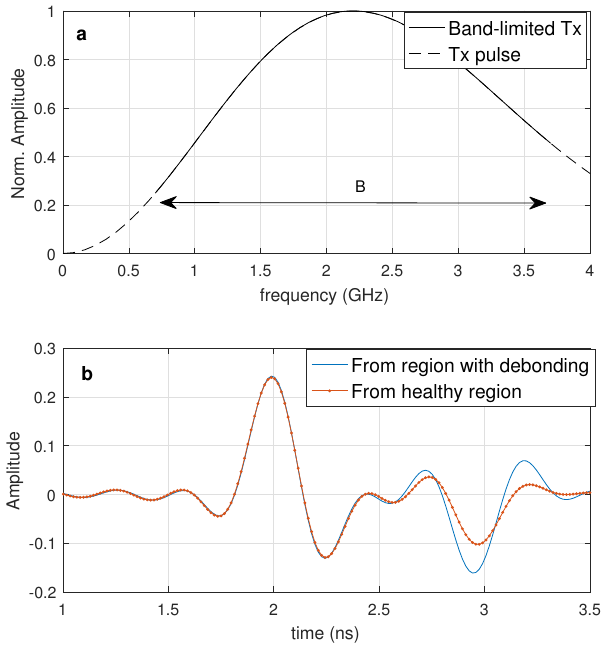
Figure 2. ( a ) Ricker pulse in the frequency domain with B = 3GHz; ( b ) noiseless simulated signals over the debonded ( d 2 = 0.5cm) and the healthy regions of the pavement structure shown in Figure 1. To test the time resolution capability of the selected TDE algorithms in Section 5, the debonding thickness d 2 was varied from 0.05 cm to 3.97 cm, corresponding to a